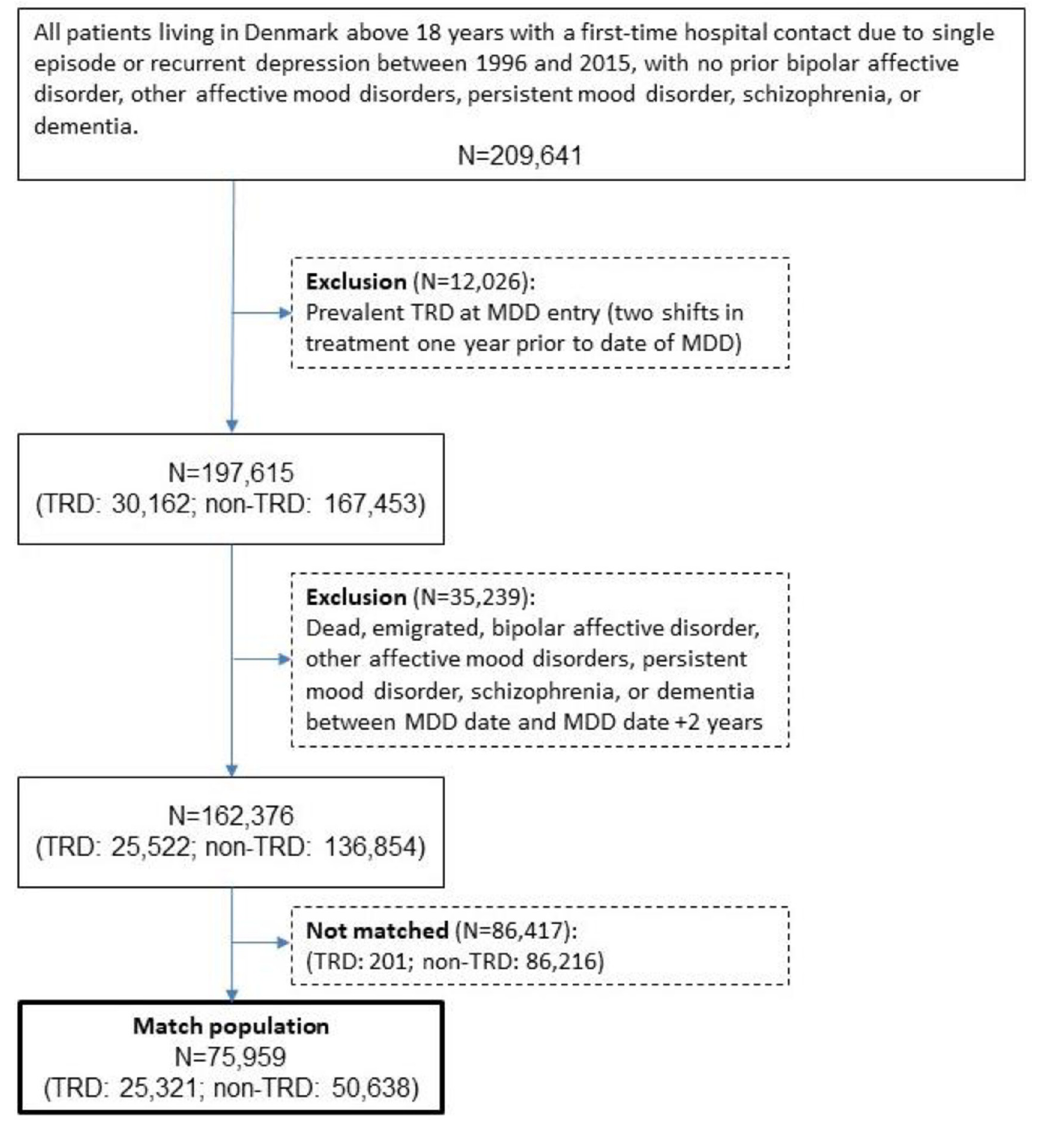
Fig 1. Flowchart of the study